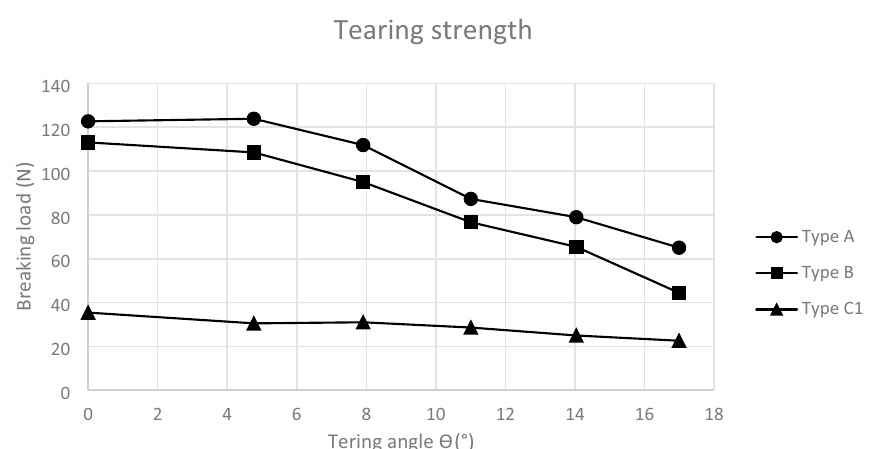
Fig. 13 Breaking load as a function of tearing angle